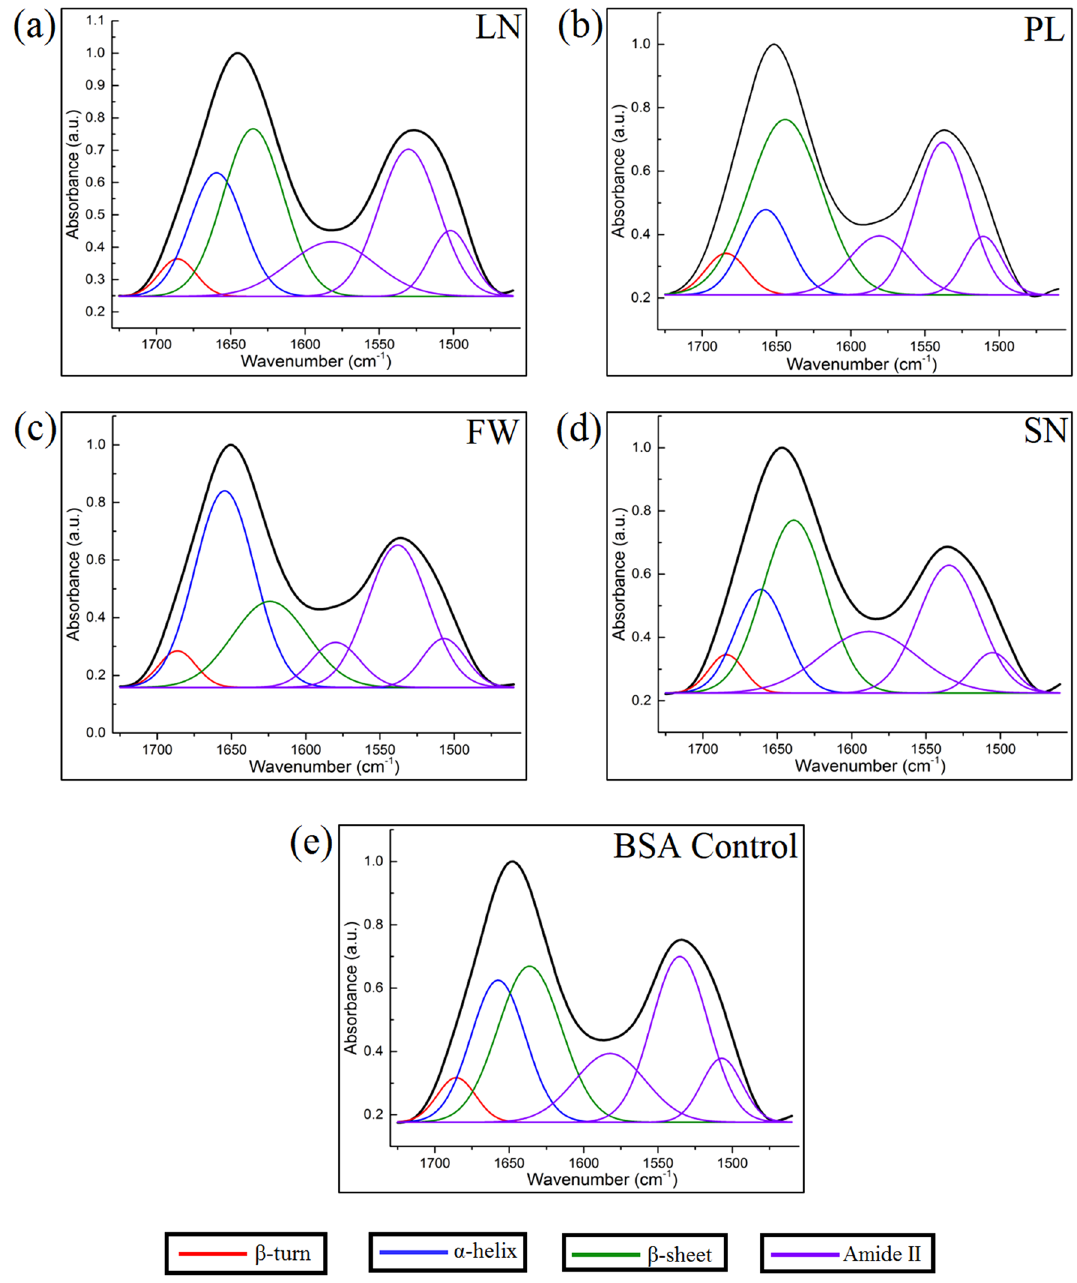
Figure 7. Deconvolution of the amide region of FTIR spectrum of adsorbed BSA on HA/CHA samples with ( a ) long-needle (LN), ( b ) plate-like (PL), ( c ) flower-like (FW), and ( d ) short-needle (SN) microstructures and in ( e ) of lyophilized